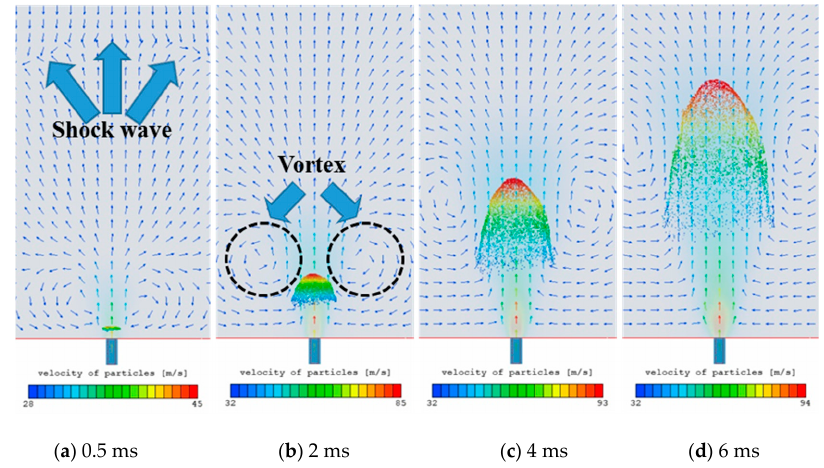
Figure 11. The simulated dispersion process of the quartz sand particles with an average diameter of 0.42 mm. ( a ) at 0.5 ms; ( b ) at 2 ms; ( c ) at 4 ms; ( d ) at 6 ms.